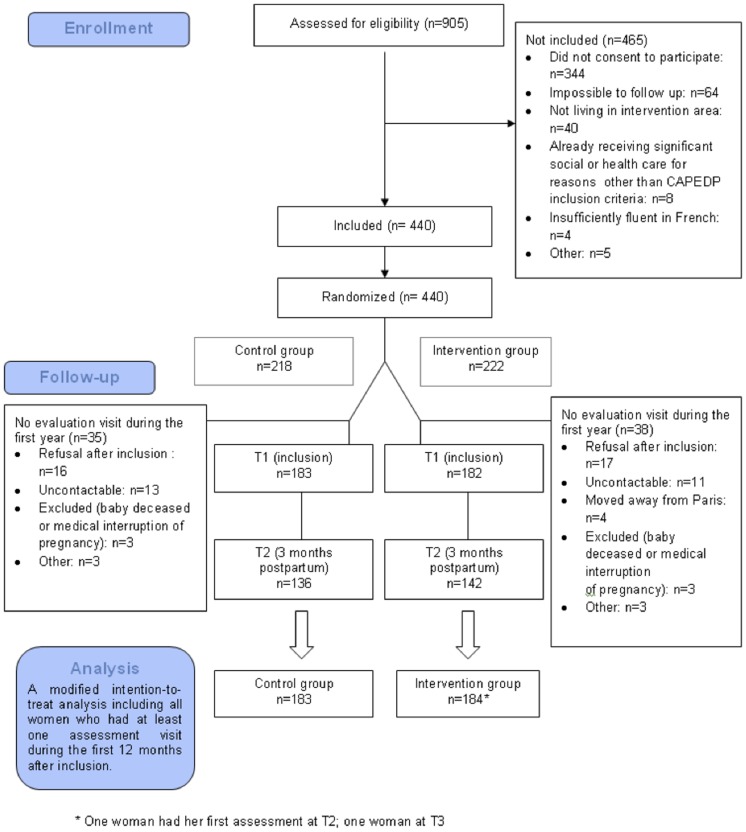
CAPEDP Flowchart Diagram.